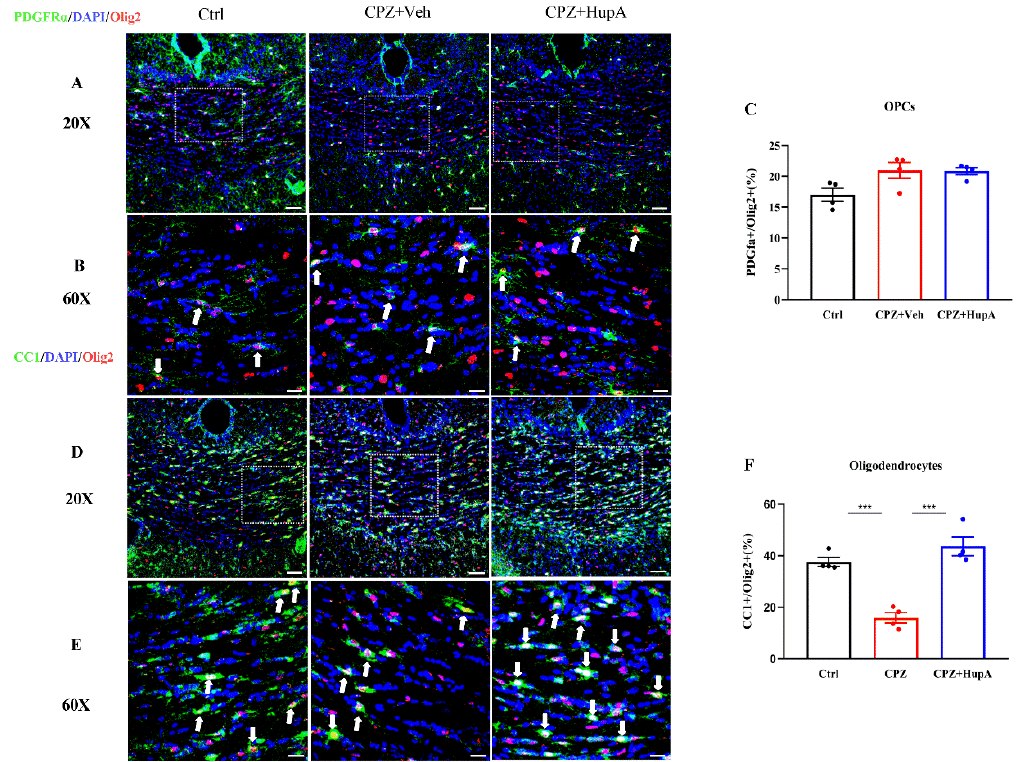
Figure 4. HupA did not display any effect on the amount of PDGFRα + Olig2 + OPCs but increased the amount of CC1 + Olig2 + mature oligodendrocytes in the corpus callosum. ( A ) Double IHC with anti-PDGFR α and anti-Olig2 in the corpus callosum. PDGFR α (green), Olig2 (red), DAPI (blue), scale bar = 50 μm. ( B ) Partially enlarged view of figure A. White arrows represents OPCs, scale bar = 50 μm. ( C ) The percentage of PDGFRα + /Olig2 + OPCs in the corpus callosum of each group. ( D ) Double IHC with anti-CC1 and anti-Olig2 in the corpus callosum. CC1 (green), Olig2 (red), DAPI (blue), scale bar = 50 μm. ( E ) Partially enlarged view of figure D. White arrows represent the mature oligodendrocytes, scale bar = 50 μm. ( F ) The percentage of CC1 + /Olig2 + mature oligodendrocytes in the corpus callosum of each group. The results represent the mean ± SEM (*** p < 0.001, n = 4 mice per group).